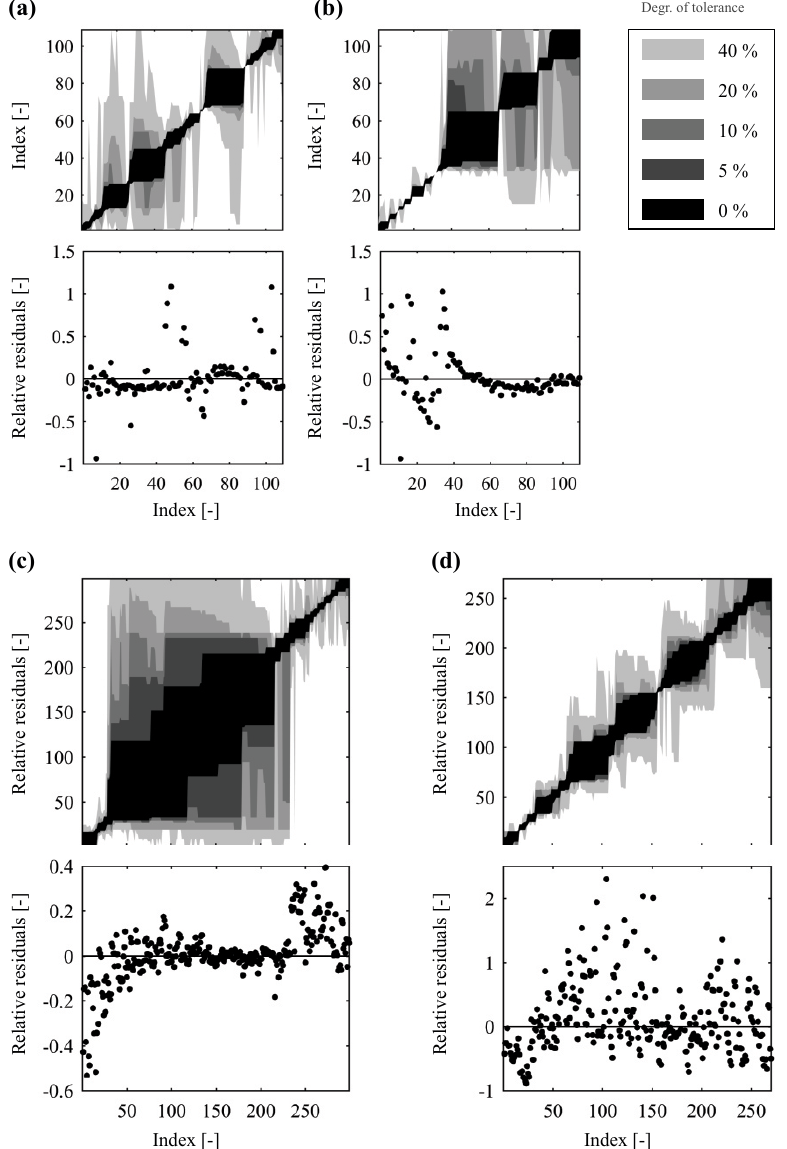
Figure 13. Combined BReach t_2s plot (all data) and relative residuals of the E RMS optimized rating curve for (a) Maaseik, (c) Aarschot and (d) Barnett’s Bank. Combined BReach h_1s plot (all data) and relative residuals of the E RMS optimized rating curve for Maaseik. In all BReach plots, for each index on the x axis the gray area indicates the span between the index of the maximum left reach (under the bisector) and the maximum right reach (above the bisector). Each gray tint represents a different degree of tolerance (i.e., percentage of data points allowed to have nonacceptable model